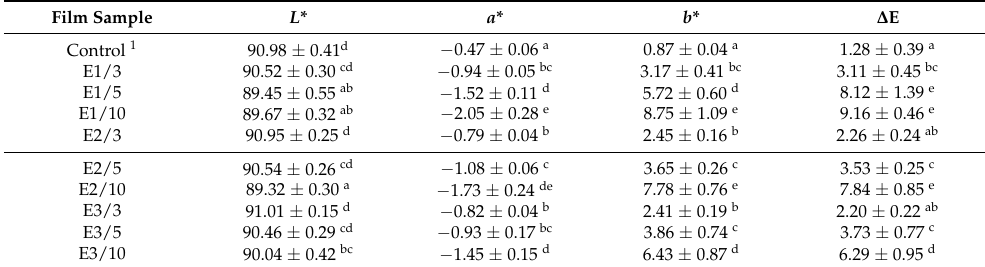
Figure 1. Appearance and transparency of pullulan film with propolis extract. Control pullulan film (C), pullulan films: with extract from Bochnia County propolis (E1); with extract from Siedlce County propolis (E2); with extract from Ełk County propolis (E3). Table 1. Color parameters ( L *, a *, b *) and total color difference ( ∆ E) of pullulan film with propolis